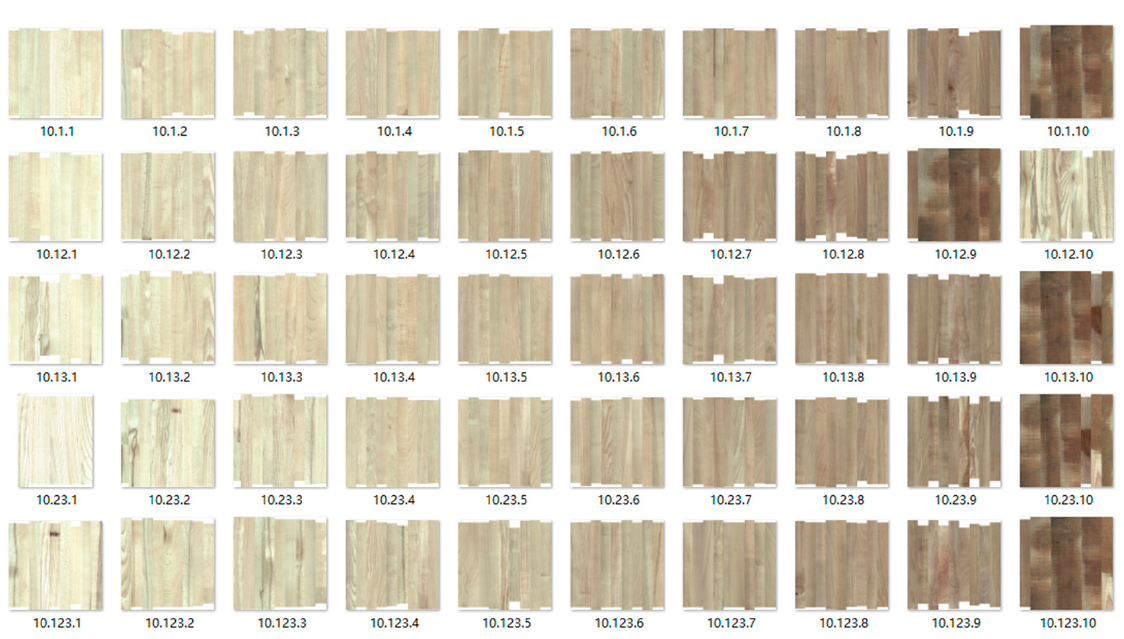
Figure 8. K = 9 clustering result images.